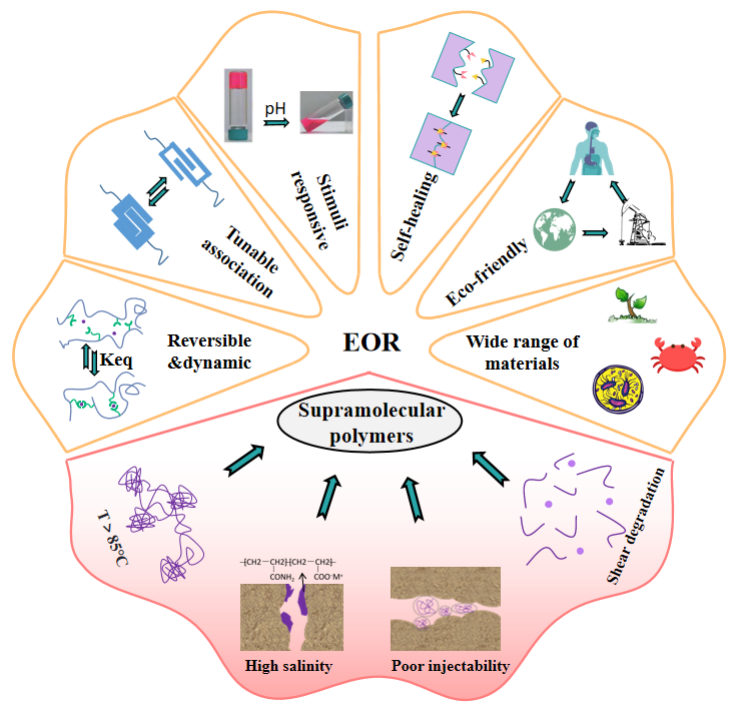
Figure 2. Display of supramolecular polymers and the limitations of conventional polymers. Supramolecular polymers are expected to solve the challenges faced by conventional oil displacement polymers with a series of unique advantages.